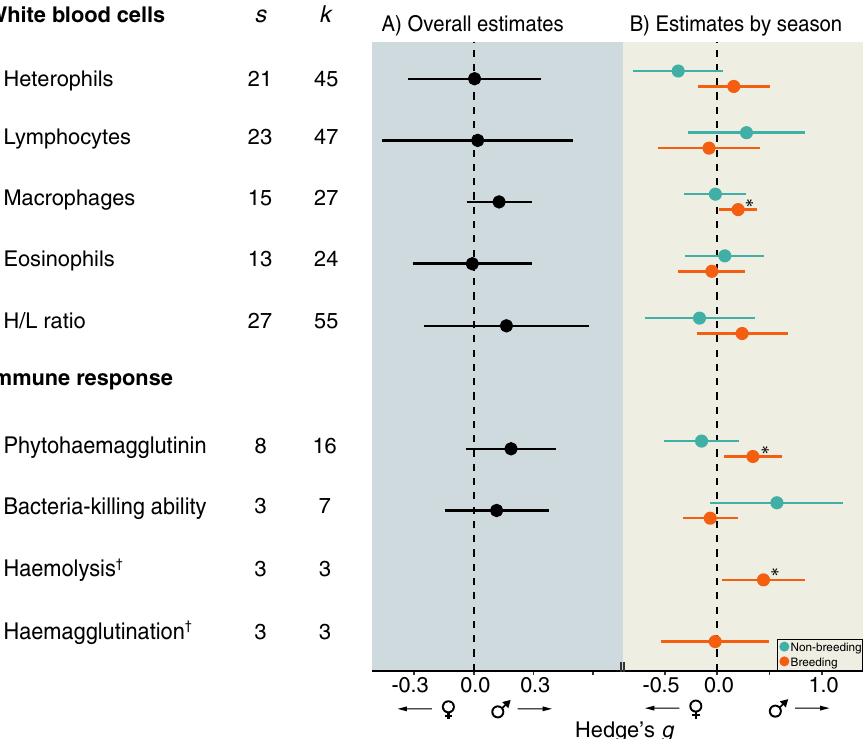
Figure 1. Sex bias in white blood cells and immune response assays in adult wild birds (weighted average effect sizes and 95% confidence intervals). ( A ) Overall in immune estimates. ( B ) Immune estimates for non-breeding (in cyan) and breeding (in orange) birds. Weighted averages were tested whether they differed significantly from zero (i.e. no sex bias, dashed line; see statistics in Table 1), where positive estimates mean male bias and negative female bias. s , number of species; k , number of effect sizes; H/L ratio, heterophils/lymphocytes ratio; *statistical significance ( p < 0.05); † data from breeding birds